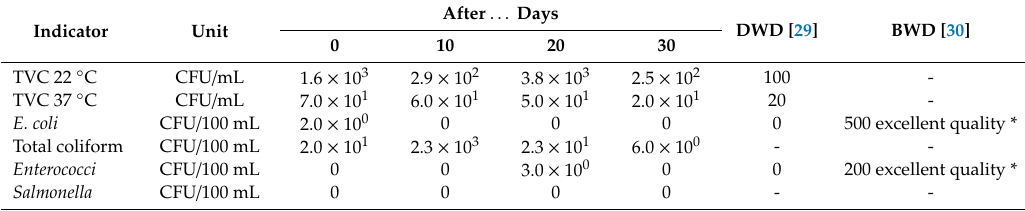
Table 2. Microbiological contamination of harvested rainwater in Bialystok area in comparison with